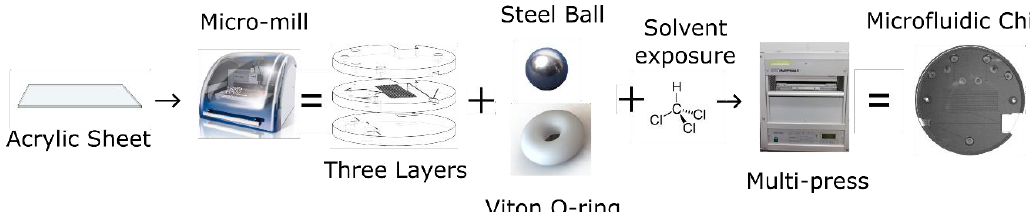
Figure 2. Process steps for manufacturing microfluidic chips with integral check valves. Sensors 2019 , 19 , x FOR PEER REVIEW